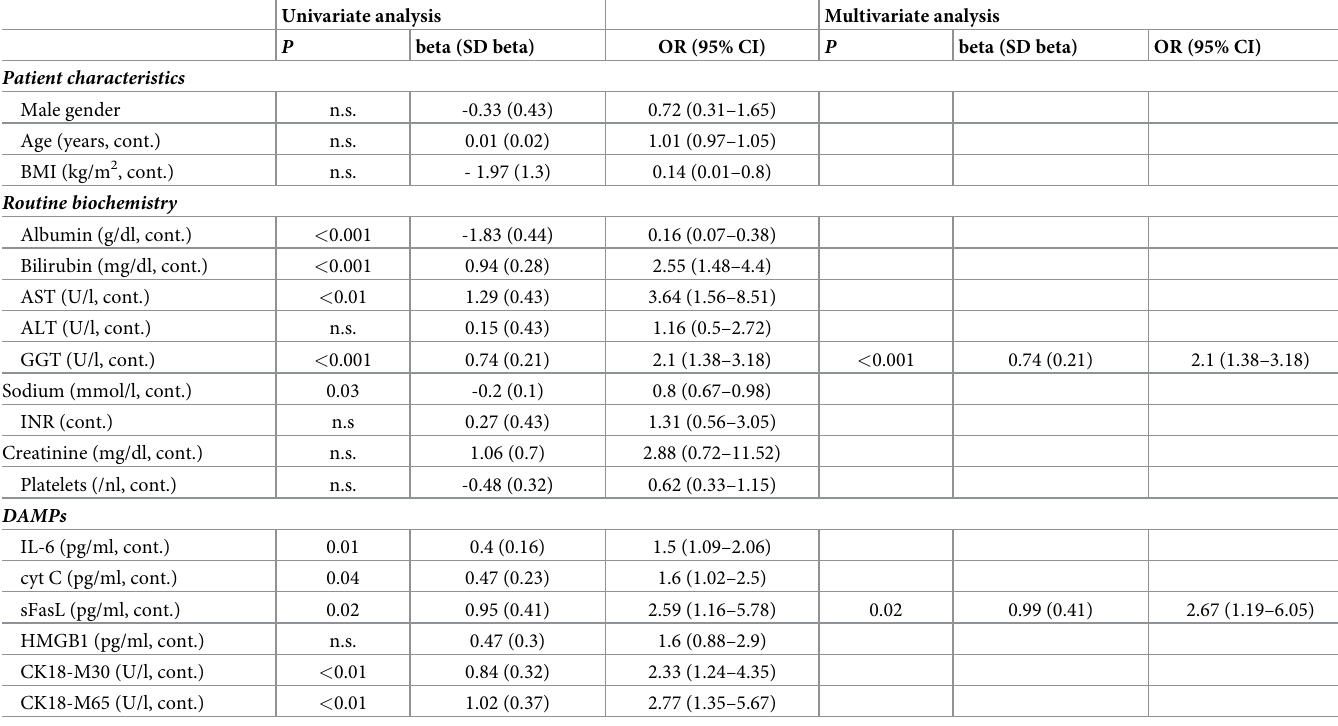
Table 4. Logistic regression analyses of patient characteristics, routine biochemistry and DAMPs to predict acute